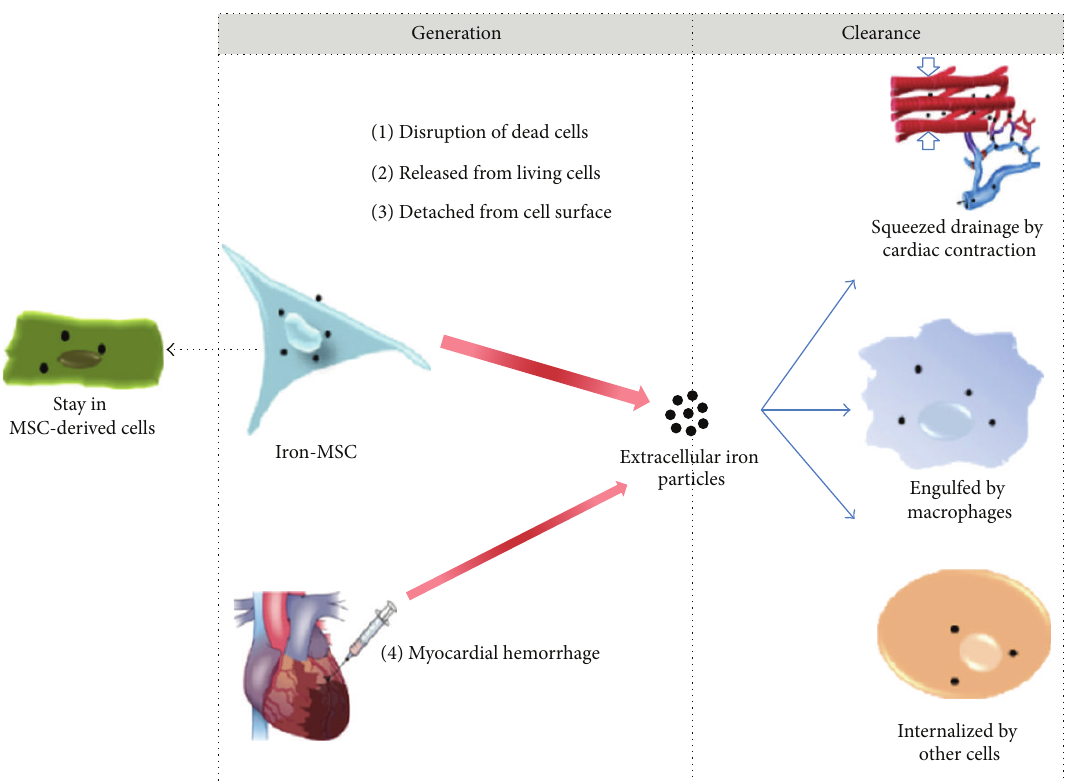
Figure 3: Schematic representation of generation and clearance of SPIONs in the myocardium (reproduced with permission [34]).